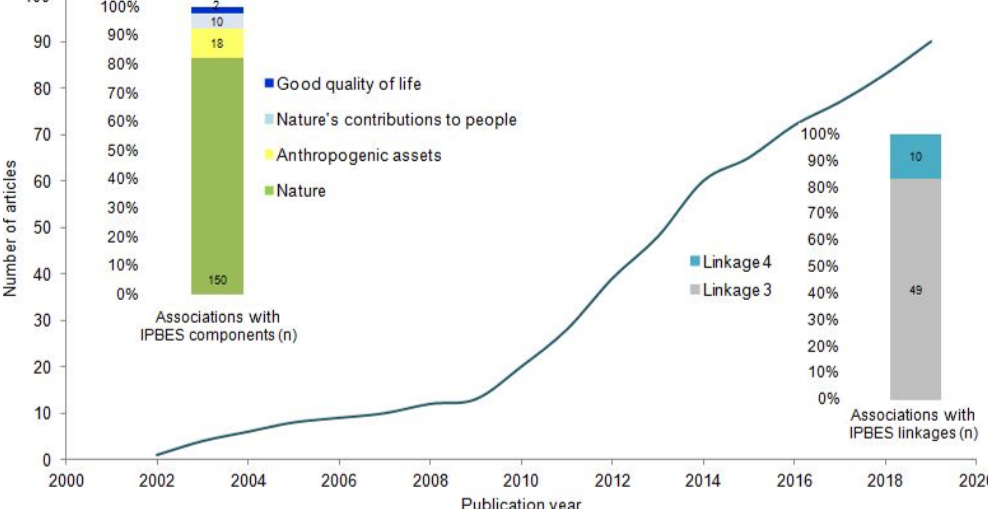
Figure 1. Evolution of the number of articles published regarding biocrust topics in Spain. Bar charts represent the contribution of these publications to the different IPBES components and linkages. Linkage numbers 3 and 4 refer, respectively, to linkage between direct drivers of change and nature and linkage between nature and nature’s contributions to